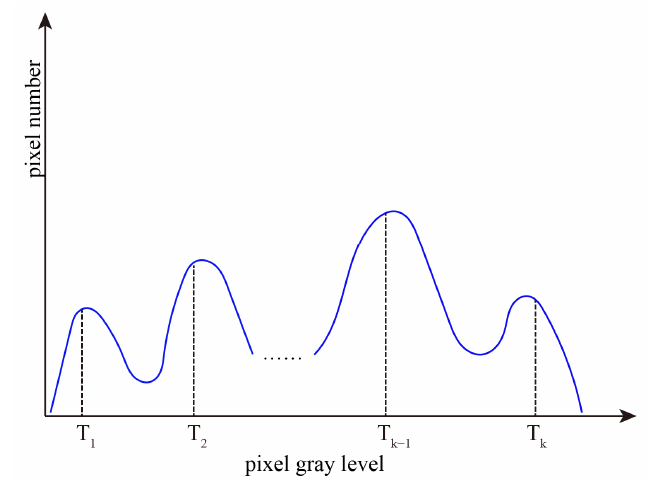
Figure 2. Final thresholds obtained by region growing.